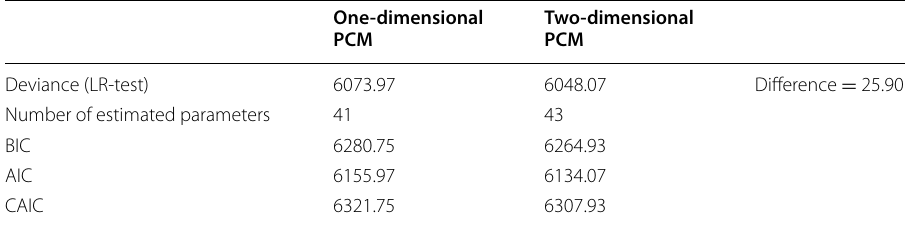
Table 2 Fit statistics for the one-dimensional PCM in comparison with the two-dimen- sional